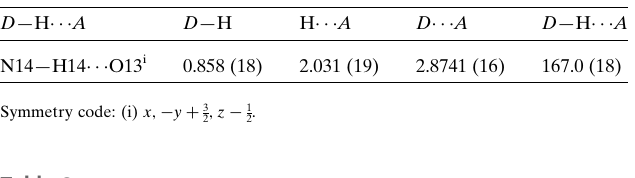
Table 2 Experimental details.